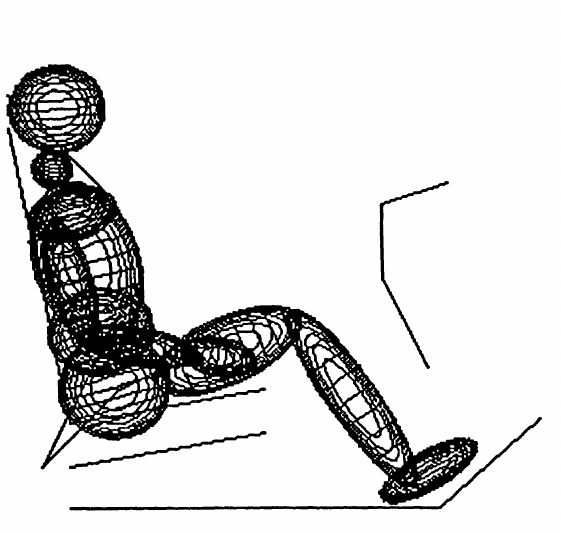
FIGURE 3 Occupant and seat model (ATB).